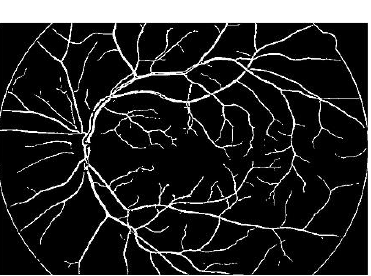
Figure 4.b. Frangi Filter